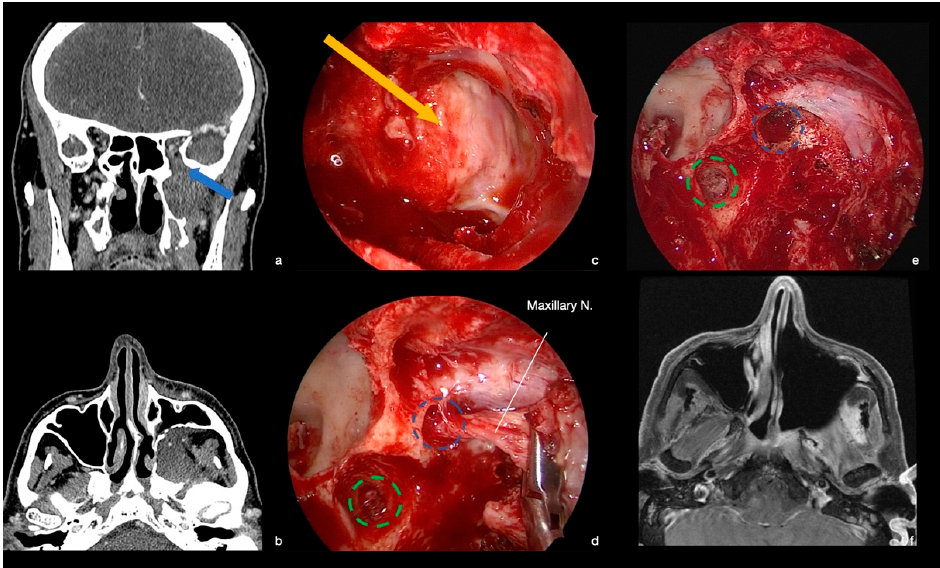
Figure 5. CT scan, MRI, and intra-operative endoscopic images (0° scope). ( a , b ) Coronal and axial NECT showing the PPF mass. An enlarged foramen rotundum, due to tumor infiltration of the maxillary nerve was observed (blue arrow). ( c ) Intra-operative image. After medial maxillectomy, at the posterior wall of the maxillary sinus, it was possible to observe a bulge directed anteriorly due to the presence of the mass in the PPF (yellow arrow). The infra-orbital nerve was evident in the roof of the maxillary sinus. ( d ) Intra-operative image. The maxillary nerve resulted infiltrated by the tumor and was resected up the foramen rotundum (blue circle), while the vidian nerve had been already resected at the opening of pterygoid canal (green circle). ( e ) Intra-operative image. At the end of tumor removal, no tumor remnants were observed and foramen rotundum (blue circle) and opening of pterygoid canal (green circle) are visible. ( f ) MRI. Axial slice. T1 w-sequence with contrast